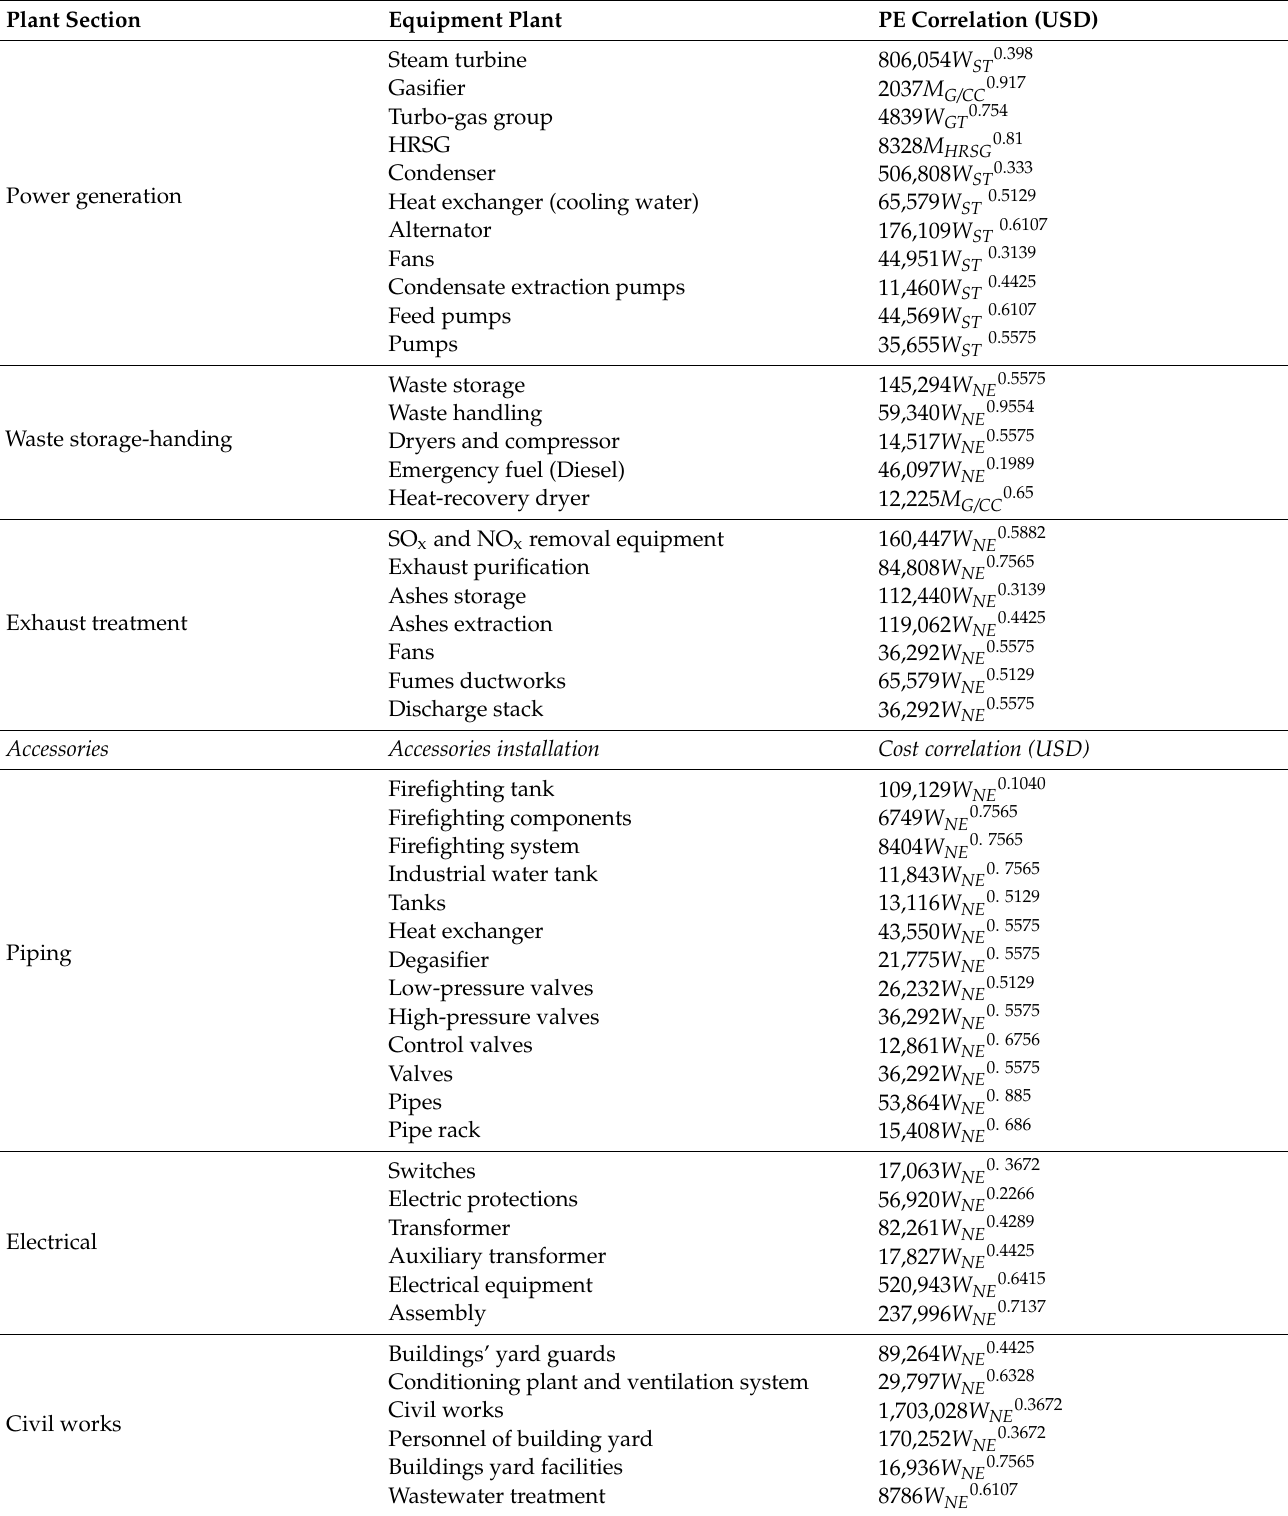
Table 2. Correlations for equipment, components, and civil work